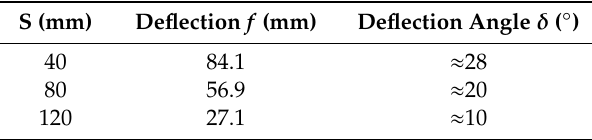
Figure 14. Discrete mobile surface with “lever effect”: ( a ) plate deflection f with different value of S ; and ( b ) airfoil NACA0011 with different bistable angles δ and deflections f .